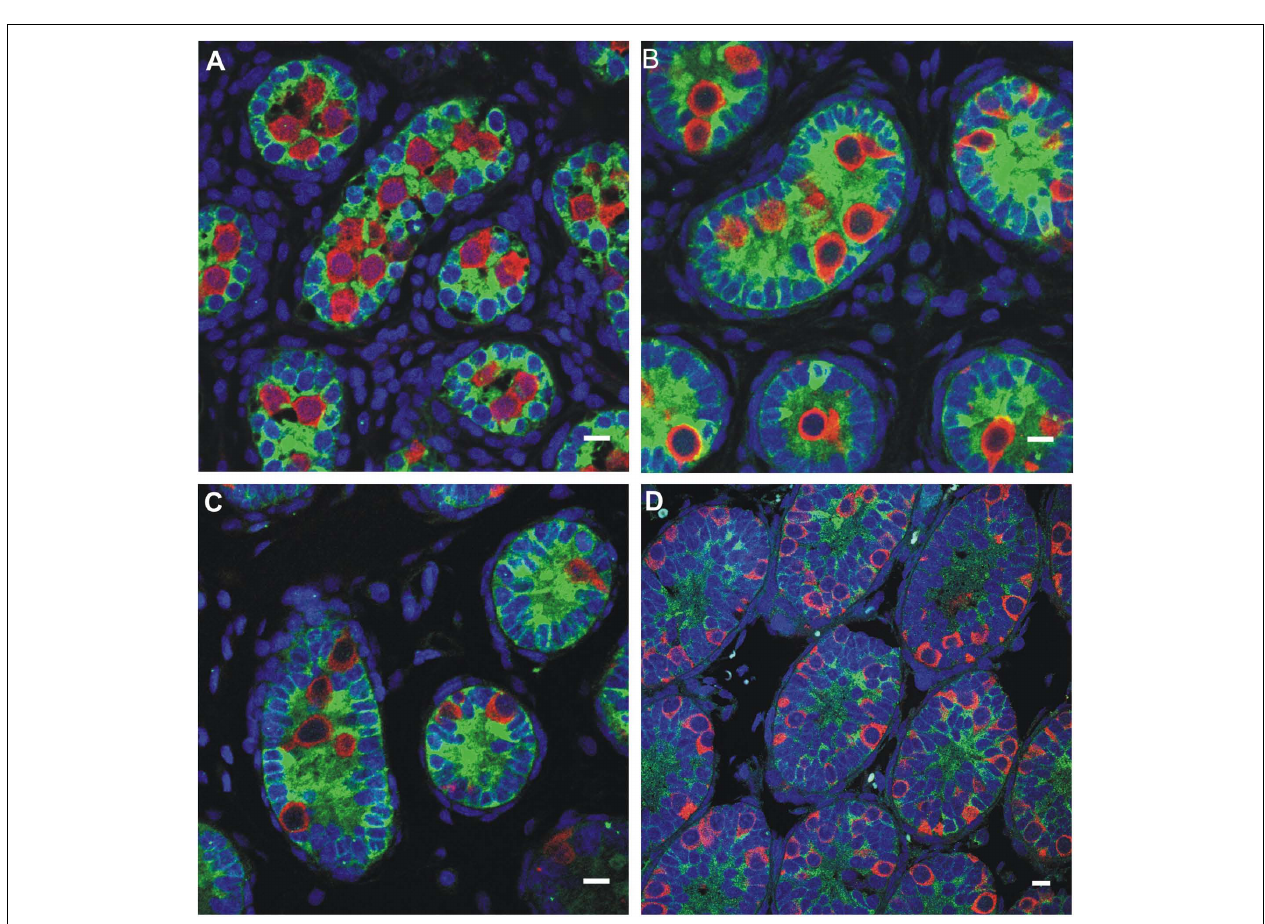
of germ cells/tubule in a normal testis and undescended testis (UDT) relative to age in years. Note the normal fall in total numbers between birth and 2 years, but failure of this to recover in UDT.The shaded area shows the normal range and the dotted lines show the average numbers.